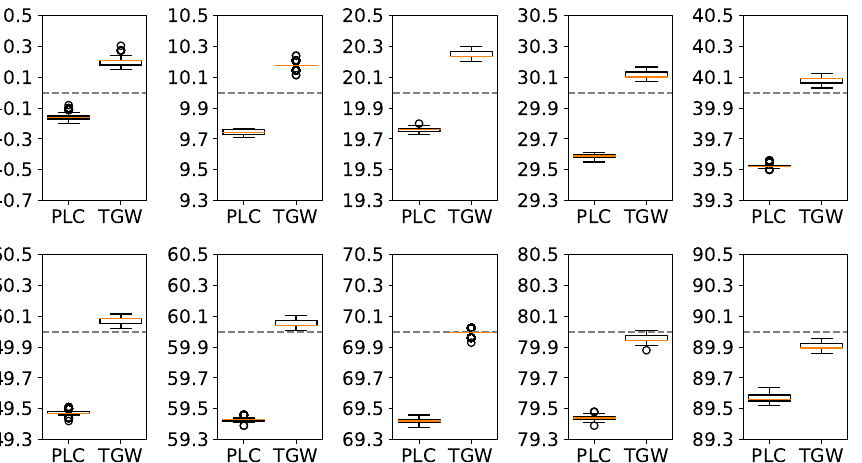
Figure 8. Results of the TGW performance test from 0°C to 90°C. The related setpoints are displayed by the gray dashed